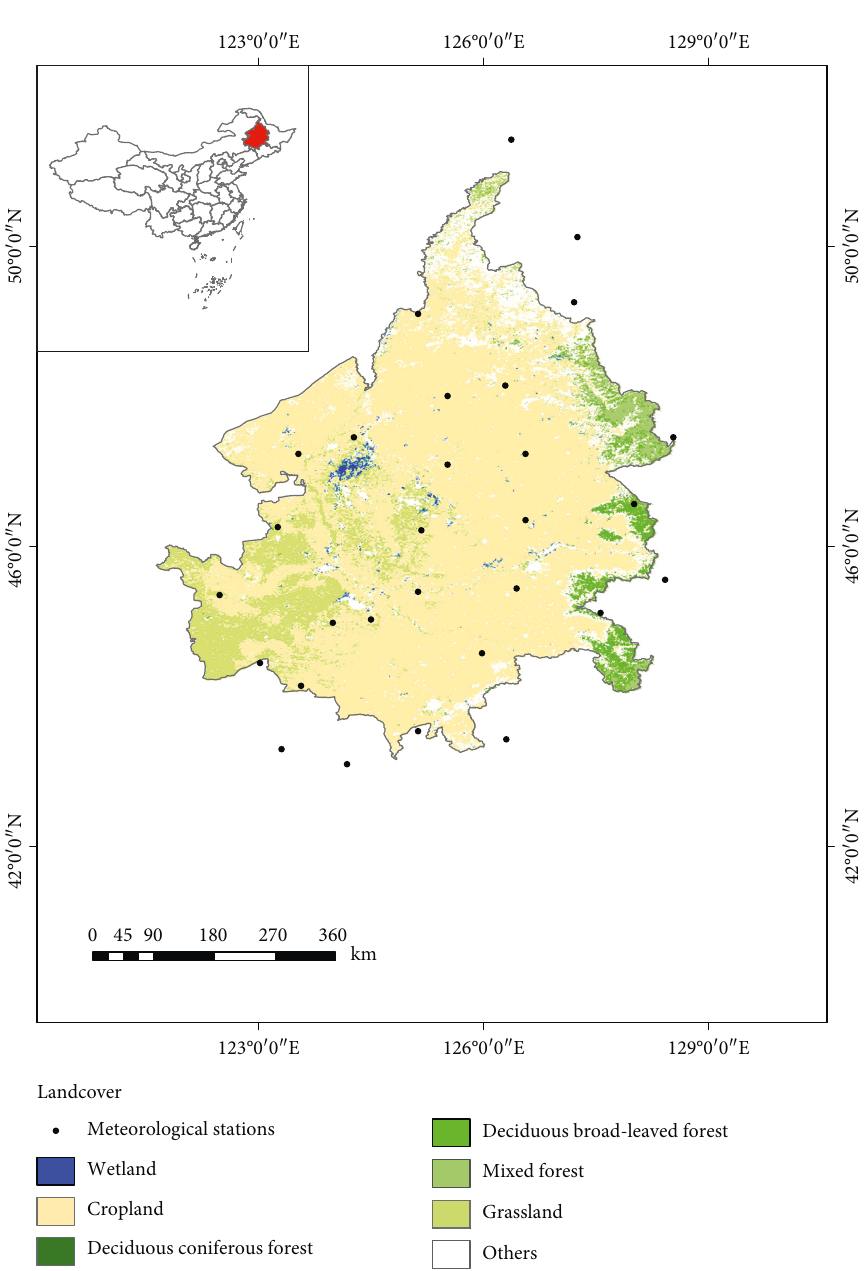
Figure 1: Location and land cover of the